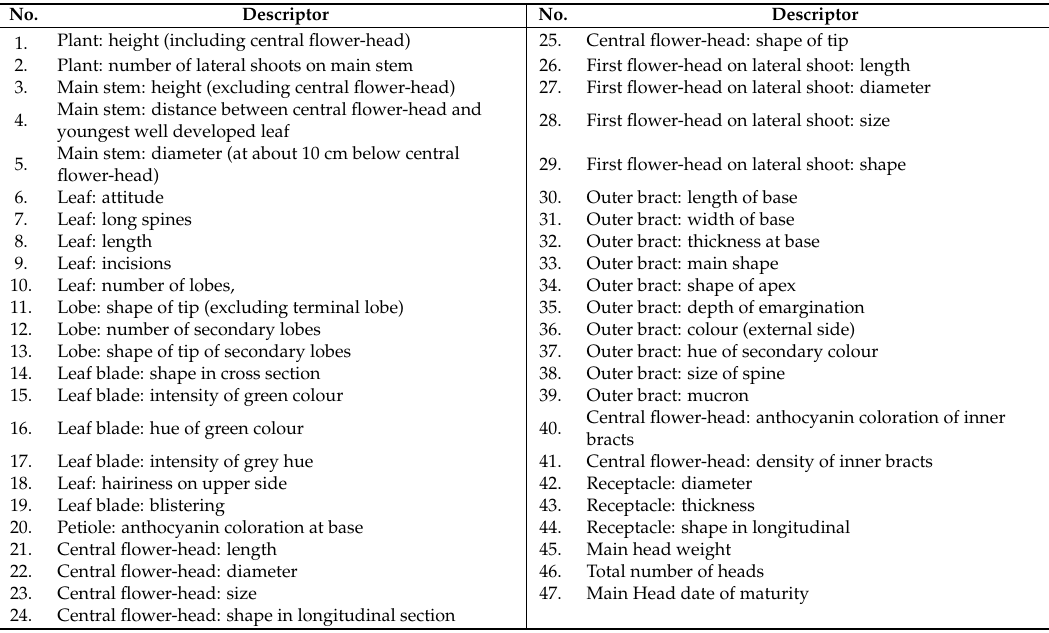
Table 1. Forty-seven morphological descriptors utilized for clone